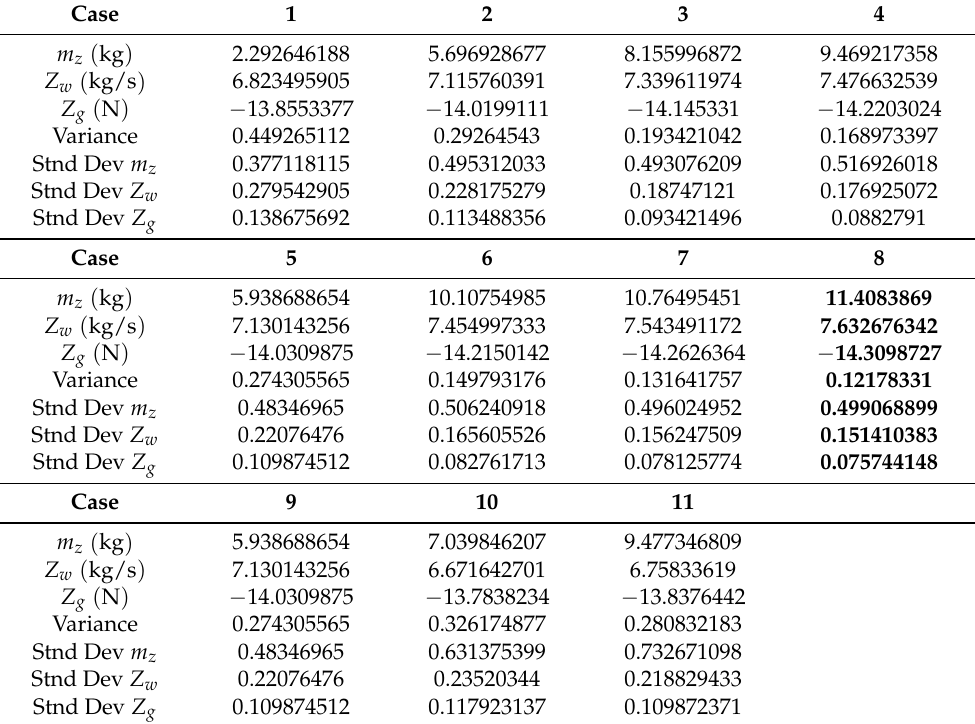
Table A4. Results of the estimation of hydrodynamic parameters for the negative motion in b z with 150